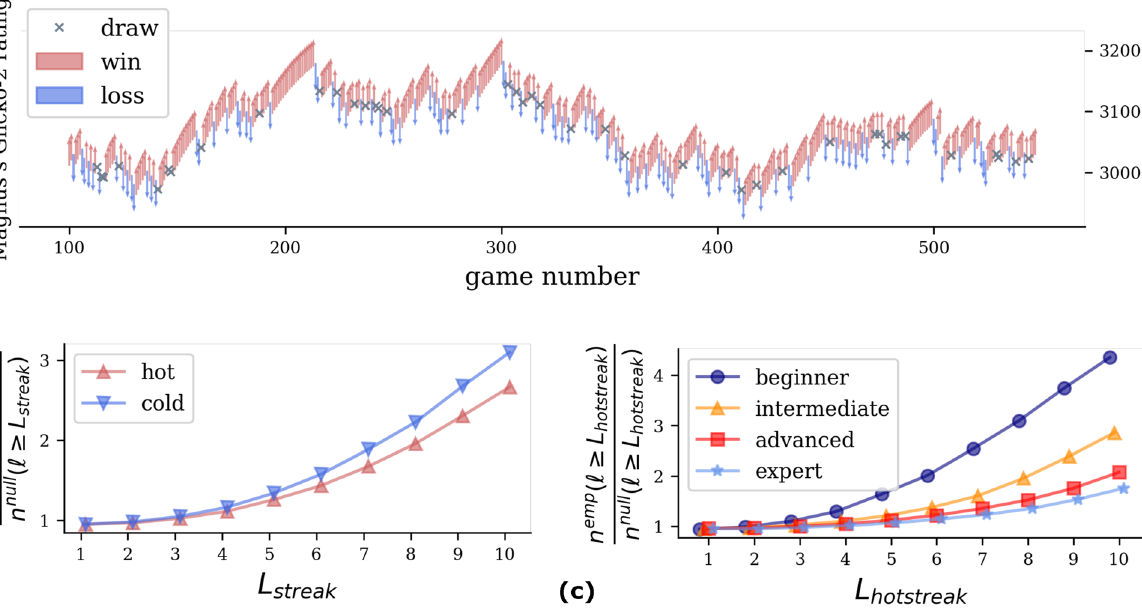
Figure 1. Hot and cold streaks in chess careers. Visualization of the career of the Grandmaster (GM) Magnus Carlsen. Wins and losses drive the Glicko-2 rating up or down. ( a ) Relative number of hot streaks (red) and cold-streak (blue) of length ℓ ≥ L streak as a function of L streak calculated for each player. Results are averaged over all players. Losses tend to be more clustered than victories as individual cold streaks are on average longer than hot streaks. ( b ) Relative number of hot streaks of length ℓ ≥ L hotstreak as a function of L hotstreak , averaged over the players in each skill categories separately (i.e. beginner, intermediate, advanced, expert). Weaker players have longer hot streaks than more expert